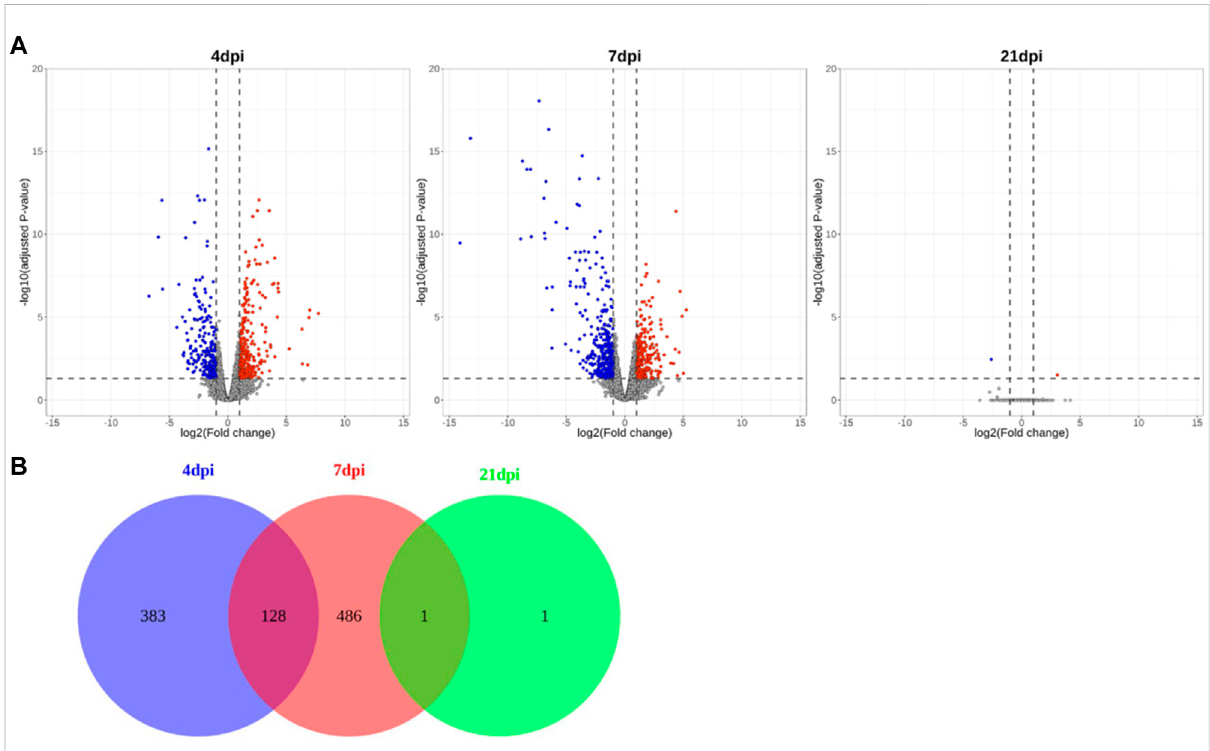
FIGURE 2 Volcano plots and Venn diagram showing signi fi cant DEGs obtained via time-series comparison between PC and NC treatments. (A) Volcano plots showing different time points, (B) Venn diagram indicating numbers of